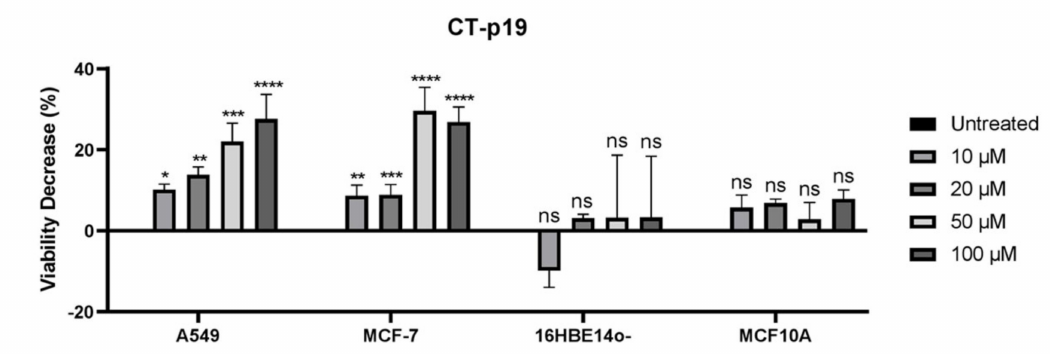
Figure 2. Viability decrease (100% of proliferation in untreated condition—% of proliferation for each treatment condition) of A549 (lung) and MCF-7 (breast) cancer cells and 16HBE14o- (bronchial) and MCF10A (mammary gland) non-cancer cells when incubated with different concentrations of CT-p19 peptide (0 to 100 µ M) over 48 h. Untreated condition (control) consisted of cells incubated with medium only. Values represent the means ± SD, and each condition had at least n = 3. *, **, ***, **** and ns denote significant differences of p < 0.1, p < 0.01, p < 0.001 and p < 0.0001 and differences that were not statistically significant, respectively, when comparing control with